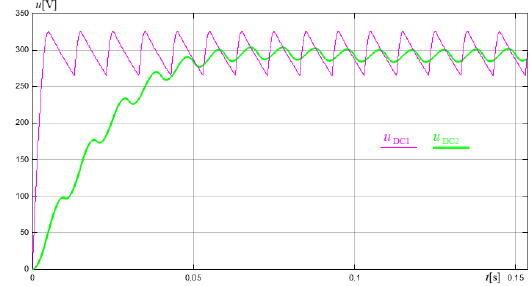
Fig. 6. Comparison of voltage ( u DC1 ) at the output of full bridge rectifier and voltage ( u DC2 ) at the output of full bridge rectifier with an input current modulator, set voltage is 300